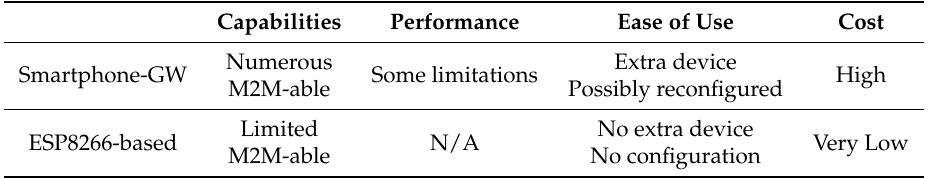
Table 1. Qualitative comparison of wearable wristbands using smartphones as GWs or ESP8266